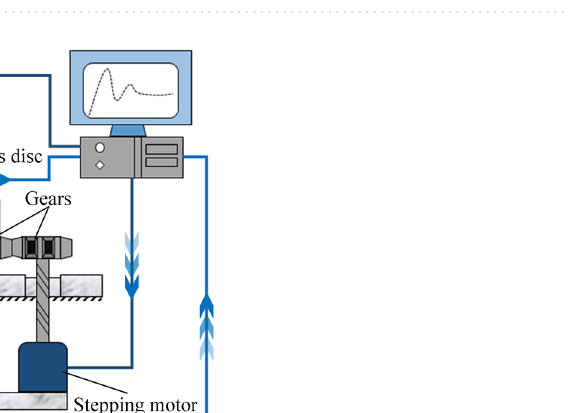
Figure 1. Surfaces of test samples S1, S2, and S3.